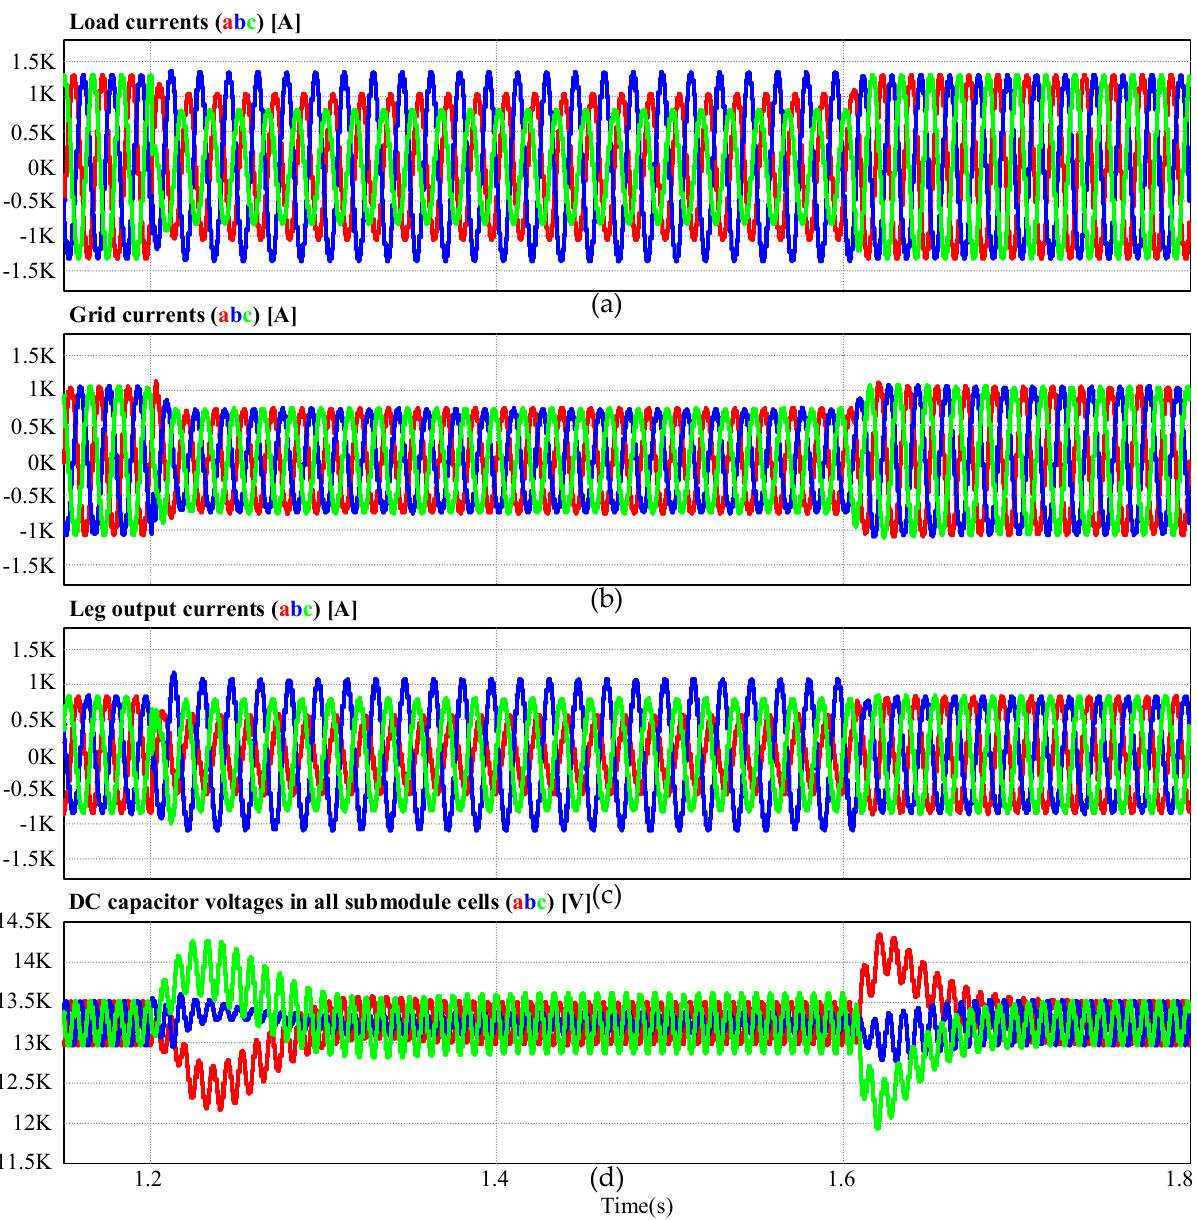
Figure 4. Simulation results under unbalanced load conditions when the feedforward is not applied: ( a ) three-phase load currents; ( b ) three-phase grid currents; ( c ) three-phase leg output currents; ( d ) DC capacitor voltages in all submodule cells.